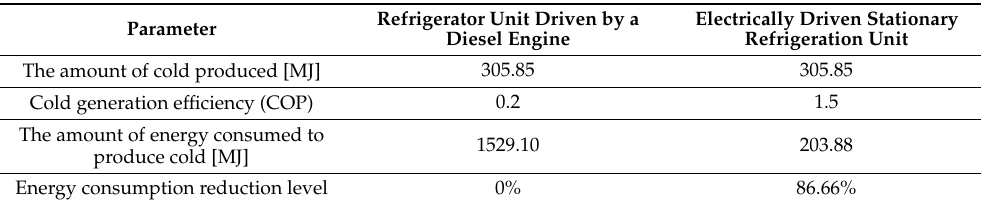
Table 6. The results of calculations of potential energy savings resulting from application of the proposed wall structure with 6 mm PCM layer in a refrigerated